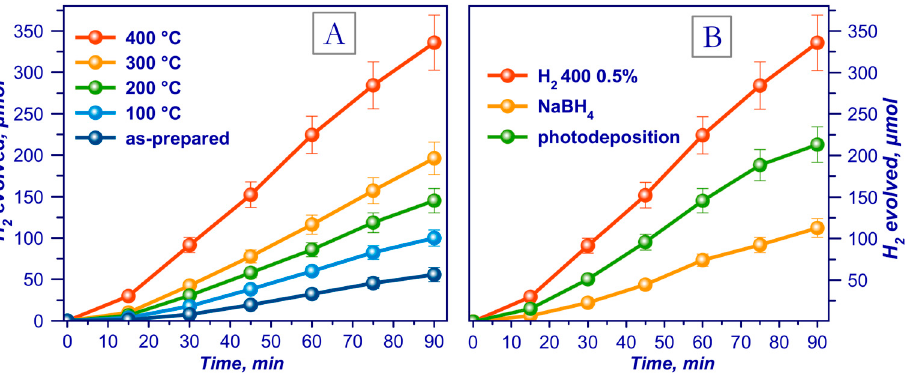
Figure 5. Kinetic curves of the photocatalytic evolution of hydrogen from an aqueous solution of triethanolamine (TEOA) over ( A ) catalysts reduced in H 2 flow at different temperatures, and ( B ) using photocatalysts reduced by various methods. Adapted with permission from Ref. [102]. 2022,